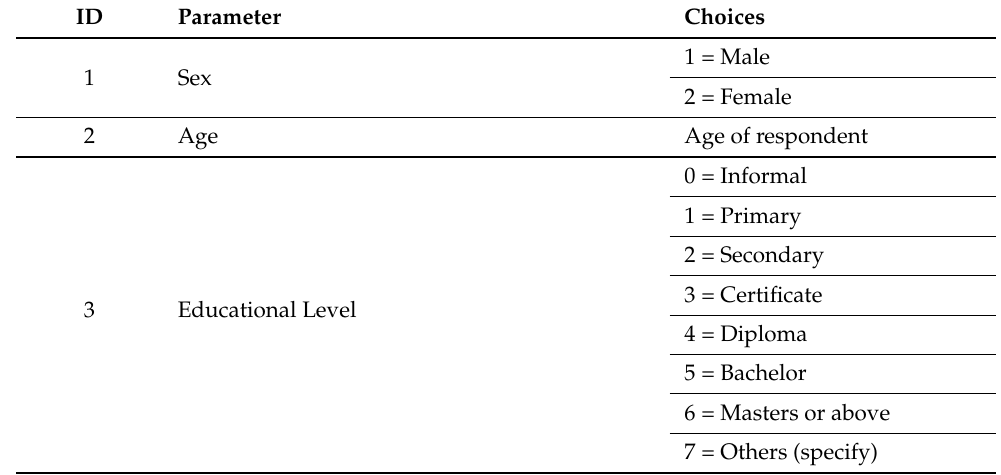
Figure 1. The Location of the three administrative regions and the synoptic gauge stations in Northern Ghana. Table 1. The Parameters recorded during the survey on farmer’s perceptions on rainfall seasonality in northern